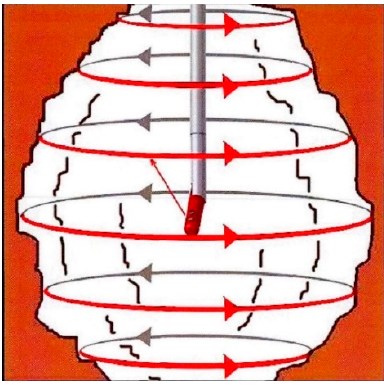
Figure 4. Horizontal scanning mode.